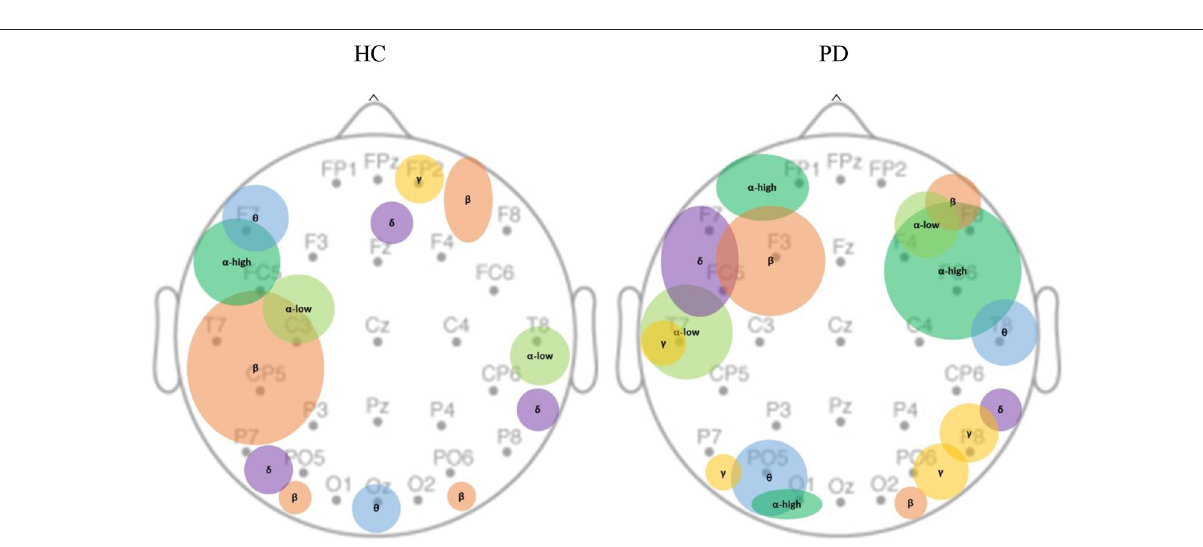
FIGURE 5 | Spatial distribution of EEG bands contributed to MV under the sham condition. MV was localized over the dominant hemisphere in healthy controls as opposed to bilateral localization in PD population. In healthy controls, theta, beta, and alpha-high are primarily concentrated in the left hemisphere; gamma is only found in the mid-frontal. In PD population, delta, beta, alpha-high, alpha-low are mostly observed in the frontal areas; theta, and gamma are mostly observed in temporal, parietal, and occipital areas. PD, Parkinson’s disease; HC, healthy controls. δ : Delta band; θ : Theta band; α : Alpha band; β : Beta band; γ : Gamma